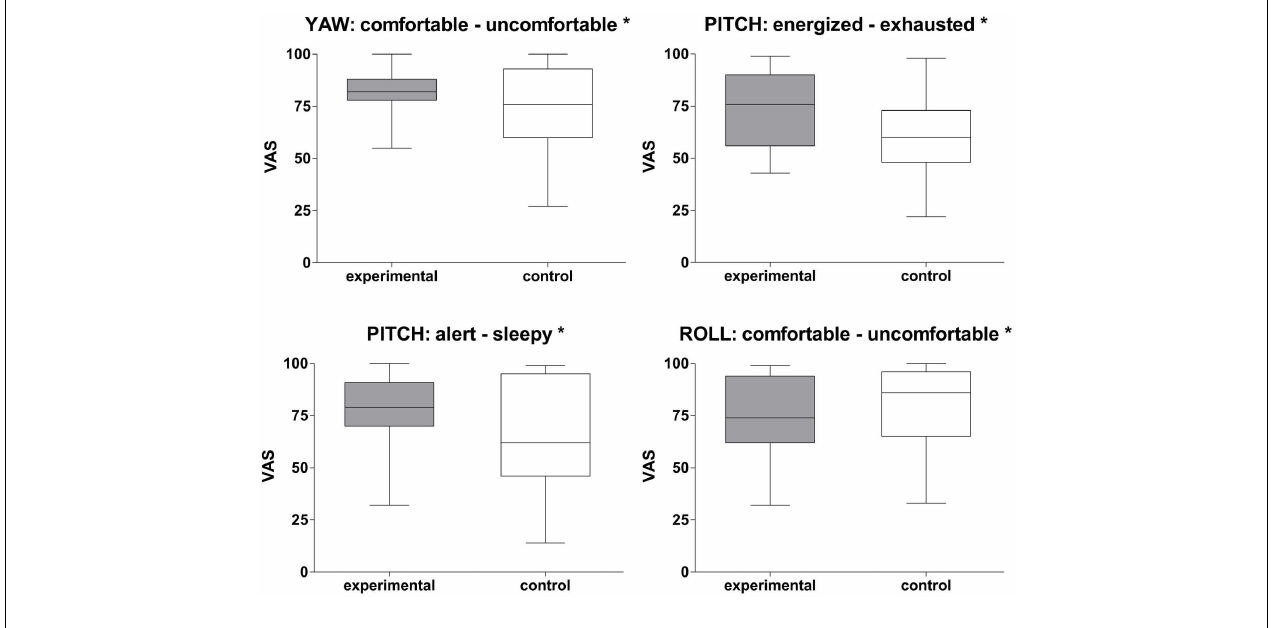
lower quartile, with whiskers showing the minimum and maximum of all values. High values on theVAS indicated that the positive adjective of the pair was appropriate and vice versa for low values. * p < 0.05.